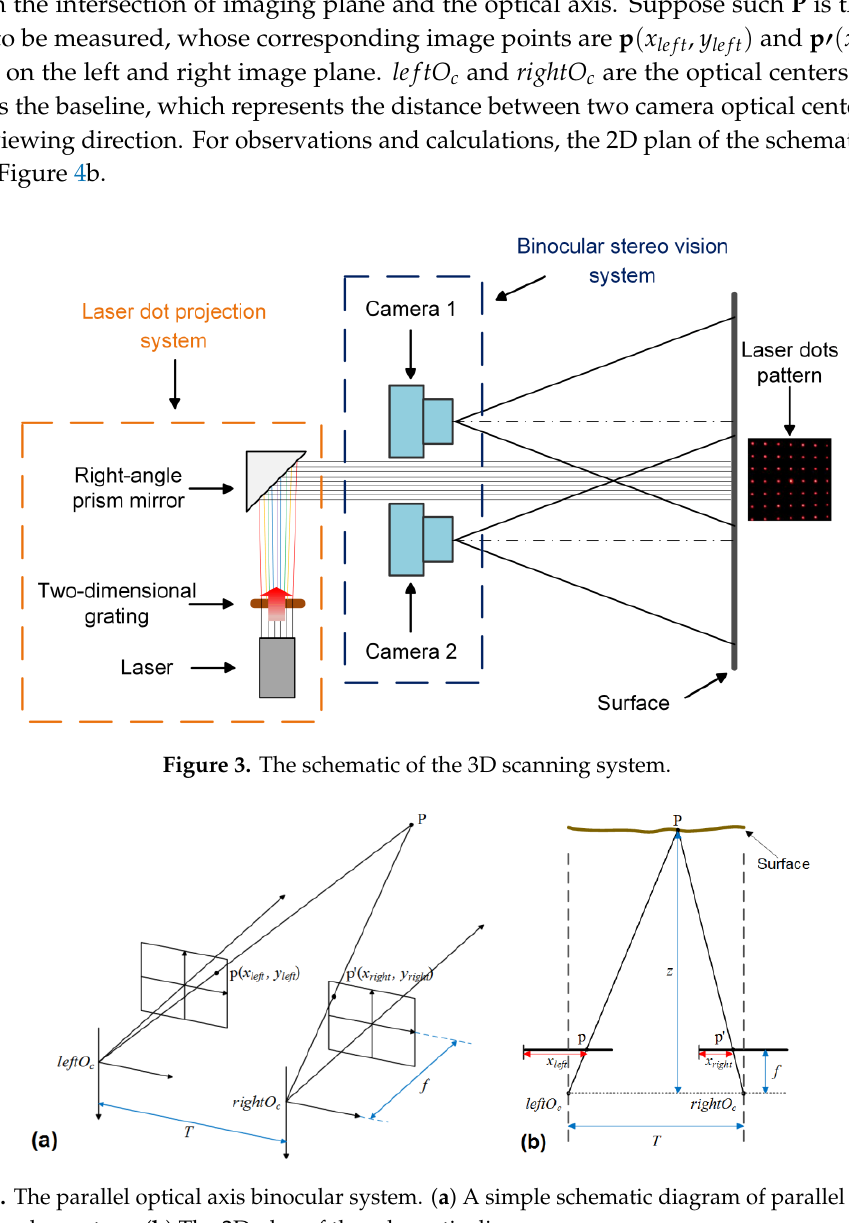
Figure 3. The schematic of the 3D scanning system.